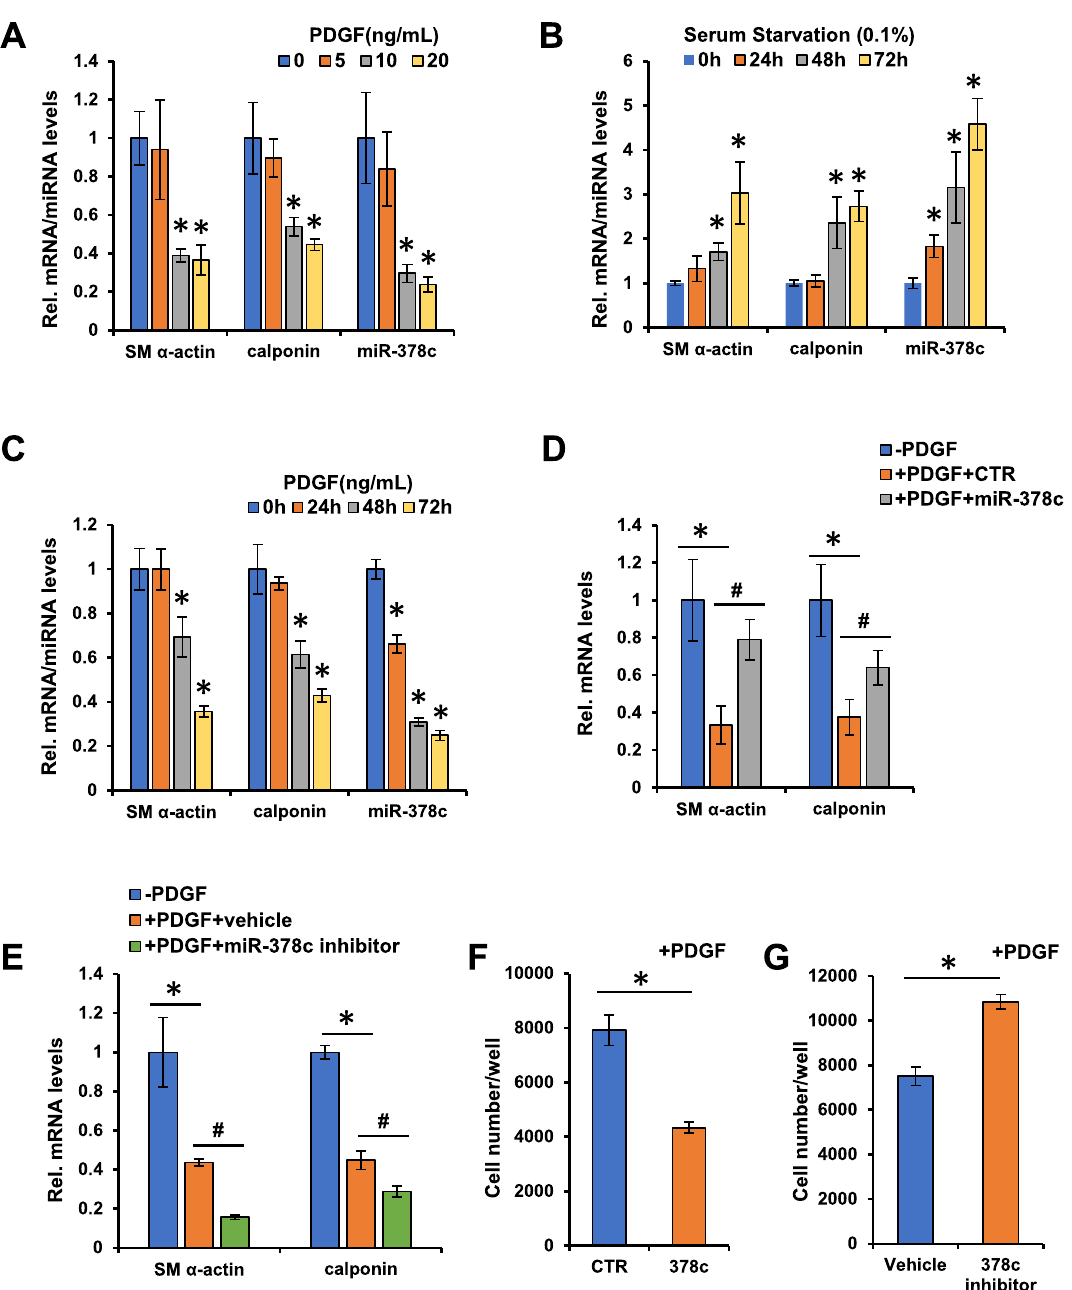
Figure 2. miR-378c suppresses VSMCs phenotypic modulation. ( A ) qRT-PCR analysis of SM α-actin, calponin and miR-378c in VSMCs stimulated with PDGF-BB for 48 h after 24 h serum withdrawal. Data were presented as mean ± SD, n = 4. *P < 0.05 as compared with non-PDGF treated group. ( B ) qRT-PCR analysis of SM α-actin, calponin and miR-378c in serum-starved (0.1%) VSMCs. Data were presented as mean ± SD, n = 4. *P < 0.05 as compared with 0 h group. ( C ) qRT-PCR analysis of SM α-actin, calponin and miR-378c in VSMCs treated with PDGF-BB after 24 h serum withdrawal. Data were presented as mean ± SD, n = 4. *P < 0.05 as compared with 0 h group. ( D ) VSMCs stimulated with PDGF-BB for 48 h were further transfected with miR-378c mimic or mimic control, SM α-actin and calponin were analyzed by qRT–PCR. Data were presented as mean ± SD, n = 4. *P < 0.05 as compared with non-PDGF-treated group; # P < 0.05 as compared with PDGF-treated mimic control group. ( E ) VSMCs stimulated with PDGF-BB were further transfected with miR-378c inhibitor or vehicle (DMSO), VSMC differentiation markers SM α-actin and calponin were analyzed by qRT–PCR. Data were presented as mean ± SD, n = 4. *P < 0.05 as compared with non-PDGF-treated group; # P < 0.05 as compared with PDGF- treated vehicle group. ( F ) VSMCs stimulated with PDGF-BB were further transfected with miR-378c mimic or mimic control, cell numbers were examined. Data were presented as mean ± SD, n = 4. *P < 0.05 as compared with PDGF-treated mimic control group. ( G ) VSMCs stimulated with PDGF-BB were further transfected with miR-378c inhibitor or vehicle (DMSO), cell numbers were examined. Data were presented as mean ± SD, n = 4. *P < 0.05 as compared with PDGF-treated vehicle